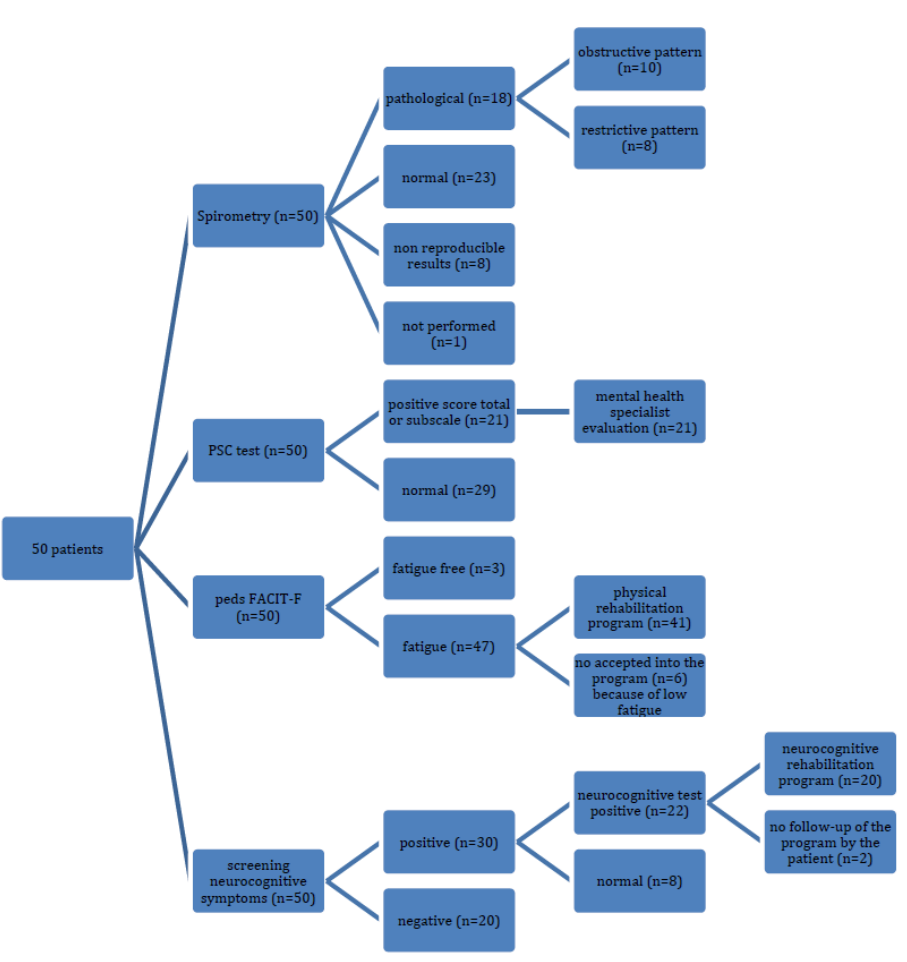
Figure 3. Flowchart of patients offered rehabilitation programs, psychiatry evaluation, and spi- rometry. Table 2. Effects of long COVID on the physical activity of pediatric patients ( n = 41).